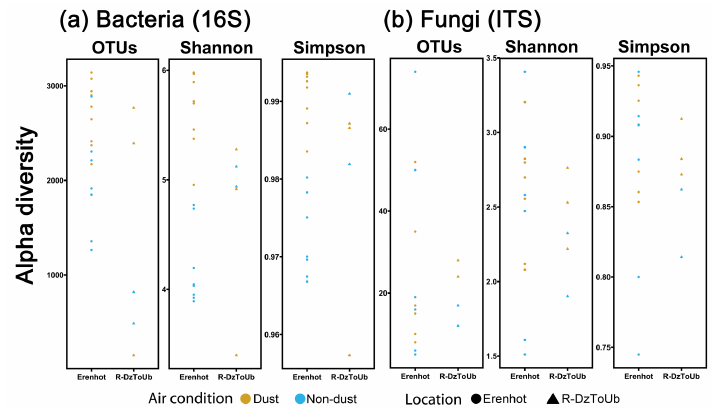
Figure 12. Alpha diversity of bacteria (a) and fungi (b) (OTUs: number of OTUs, Shannon: Shannon index, Simpson: Simpson index).